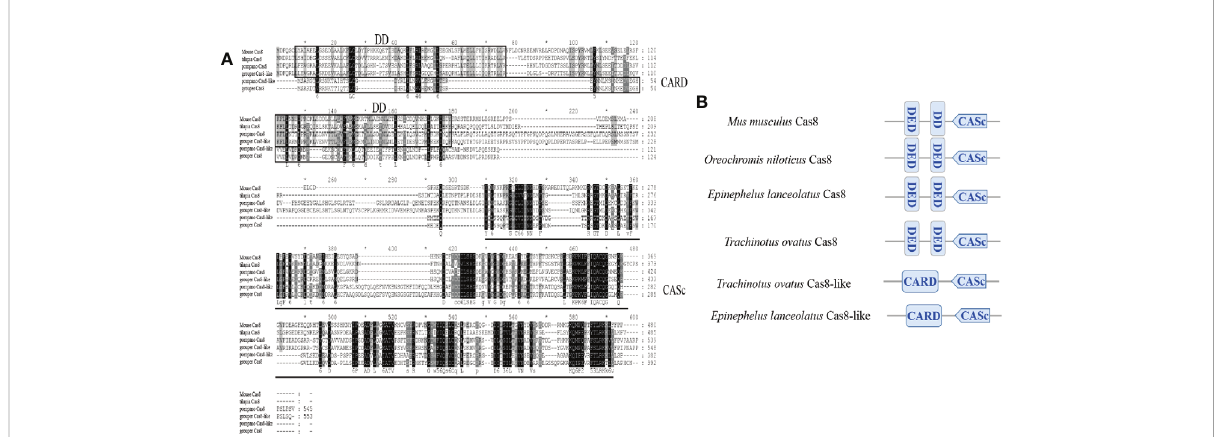
FIGURE 1 Sequence alignments and domain organization of golden pompano caspase proteins. (A) Multiple alignment of the amino acid sequences of golden pompano Caspase-8s proteins. (B) Schematic protein domain architecture of the corresponding Caspase-8 proteins in vertebrates. CARD, caspase recruitment domain; DED, death effector domain; DD, Death Domain, CASc, caspase, interleukin-1 beta converting enzyme (ICE)